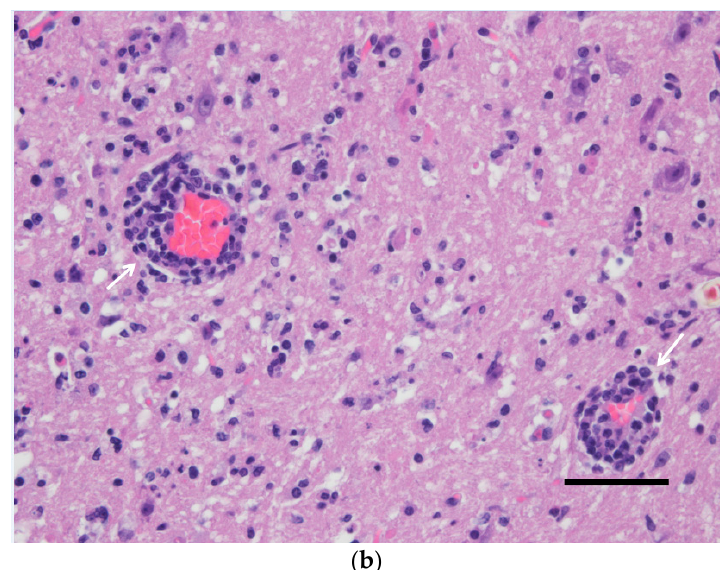
Figure 2. Spinal cord (gray matter) of a wild-type 129/Sv mouse injected with the Usutu virus via the intradermal route. Abundant neuronal death with neuronophagia and moderate satellitosis and gliosis ( a ) and lymphoplasmacytic perivascular cuffs ( b ). Hematoxylin and eosin staining. Scale bars = 50 µm, magnification 200×.